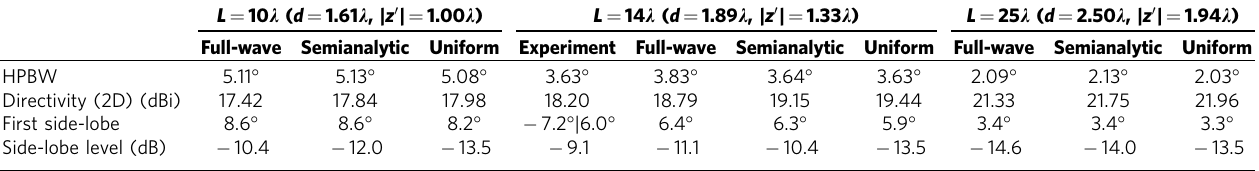
Table 1 | Radiation characteristics of cavity-excited HMS